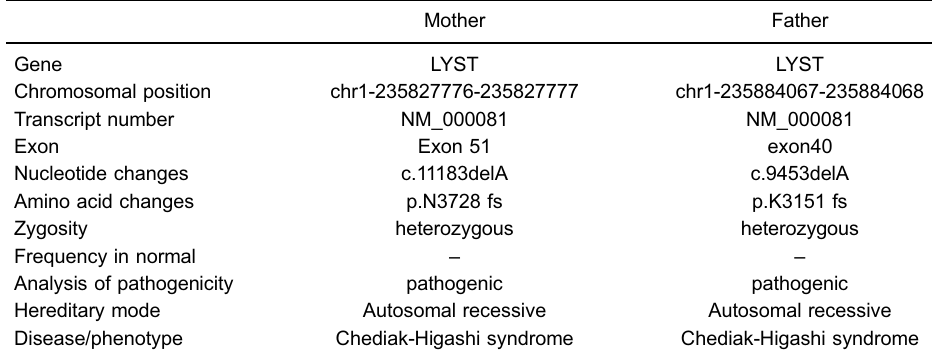
Figure 5. Gene mutations of a 9-month old boy with Chediak-Higashi syndrome and of his family. A , The boy ’ s gene mutations at c.11183delA, p.N3728fs (1)/c.9453delA, p.K3151fs (2). B , The father ’ s gene mutations at c.9453delA, p.K3151fs (2). C , The mother ’ s gene mutations at c.11183delA, p.N3728fs (1). Table 1. DNA variation of the parents of a 9-month old boy with Chediak-Higashi